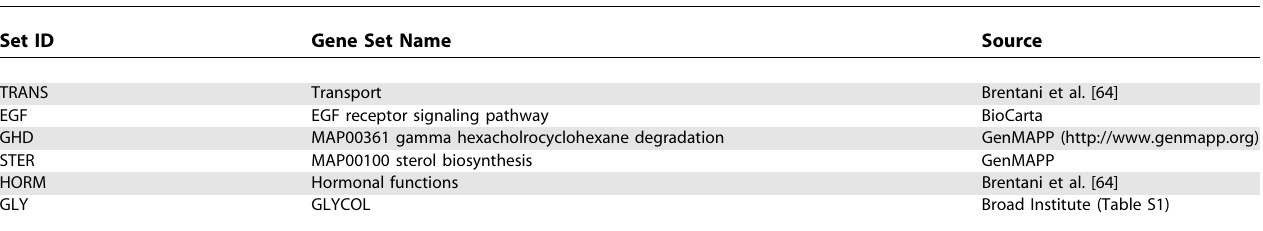
Table 5. Gene Set Names for the Gene Set IDs in Figure